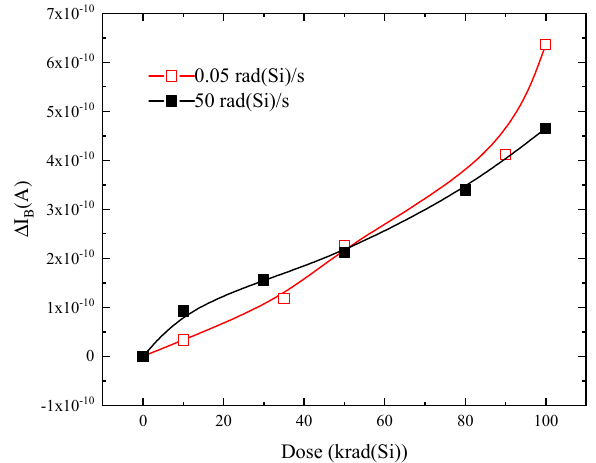
Figure 2. Gummel characteristics of a DPSA BJT before and after irradiation at the dose rate of 50 rad (Si)/s and 0.05 rad (Si)/s. V EB = emitter-base voltage; I C = collector current; I B = base current.